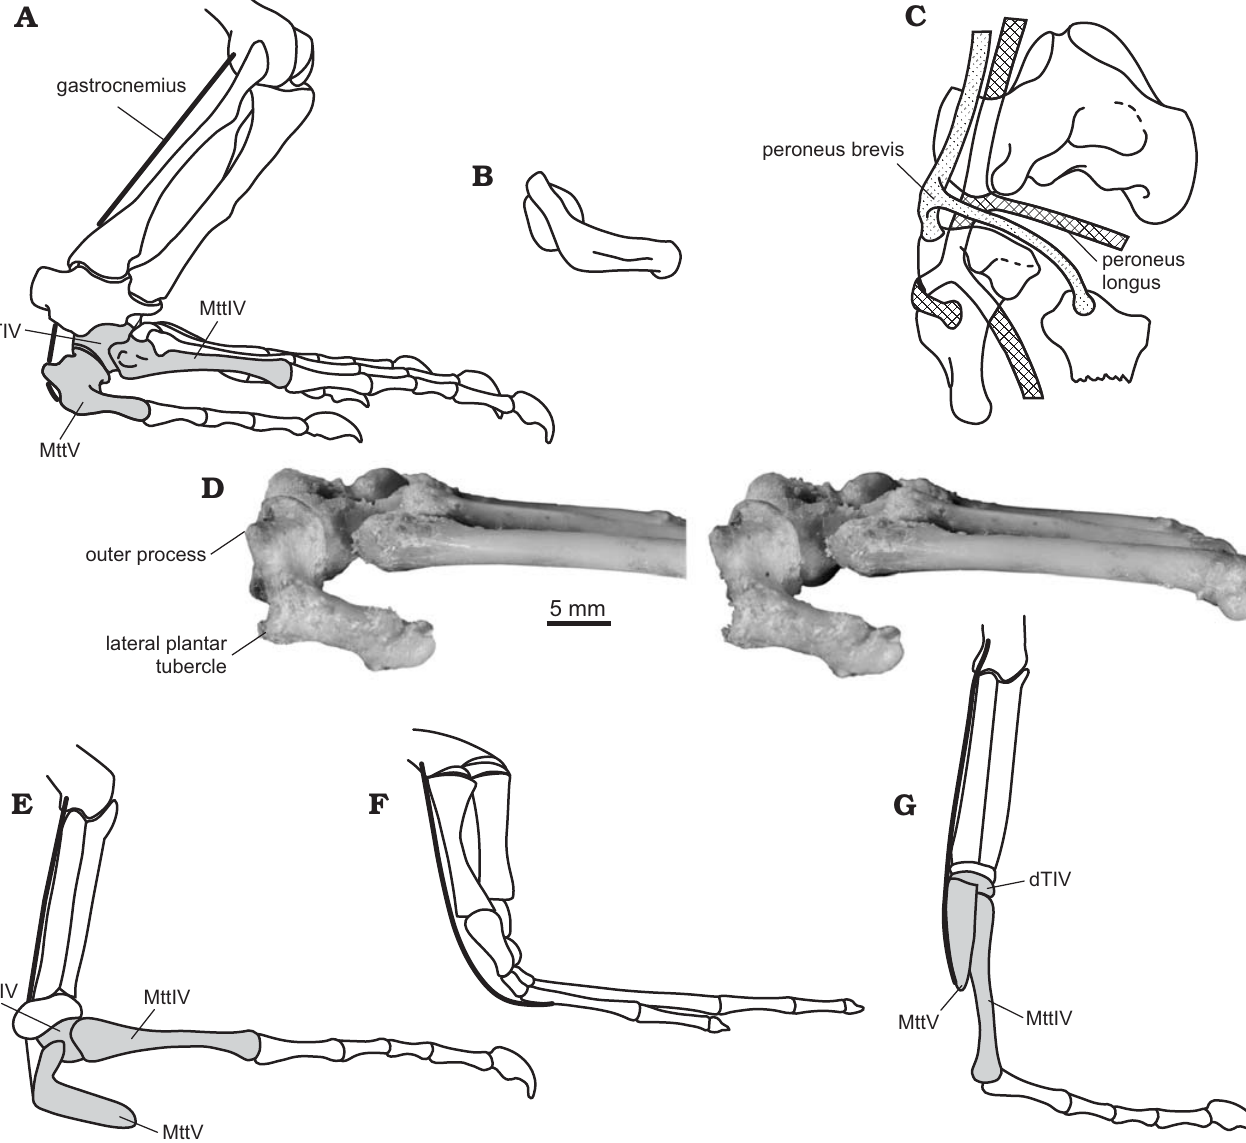
Fig. 6. General outline of muscle equipment of the lower leg and life position of the foot in Sauria. A . Varanus sp., left crus and pes in right lateral view (from Robinson 1975: fig. 8, reversed). B . Sophineta cracoviensis Evans and Borsuk-Bia ł ynicka, 2009, Lepidosauromorpha, Early Triassic, Poland, right MttV in lateral view; approximated life position. C . General courses and insertions of the peronei muscles in lizards, right pes in dorsal view (from Robinson 1975: fig. 11F, reversed). D . Varanus niloticus (Linnaeus, 1766), Recent, ZPAL z.p. RI/31, stereo-pairs of right foot: tarsus and proximal metatarsus in lateral view. E – G . Schematic drawings of foot showing proposed differences in levering conditions. E , G . Sauria. E . Plantigrade style with inflected MttV, as shown in A and D in squamates. F . Early tetrapods. G . Digitigrade style with straight